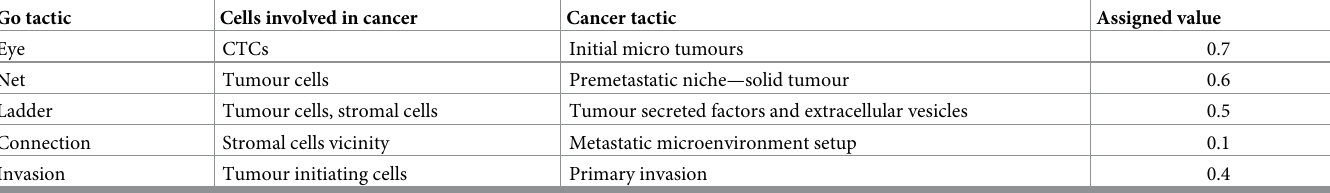
Table 1. Correspondence between cancer and immune system tactics to Go